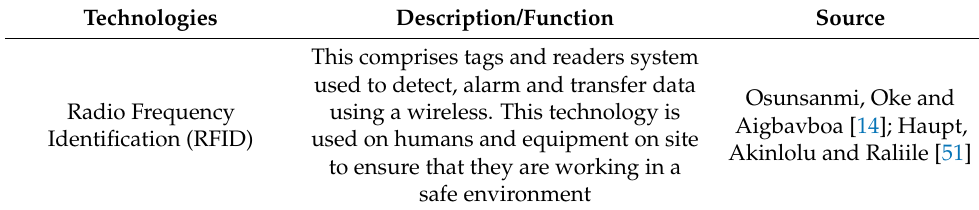
Table 1. The Available